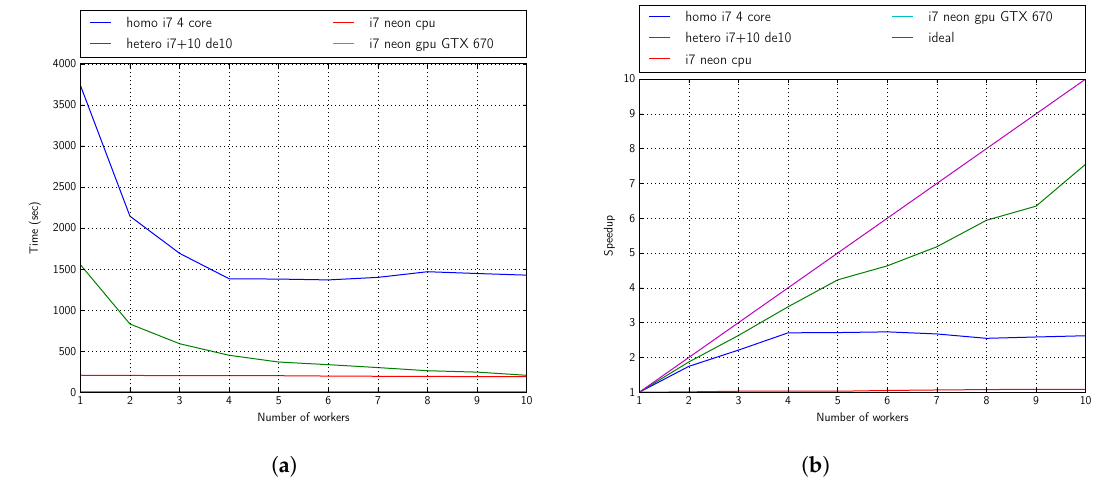
Figure 11. Performance: three generations, 16 individuals, i7 platform. ( a ) Time; ( b ) speedup.